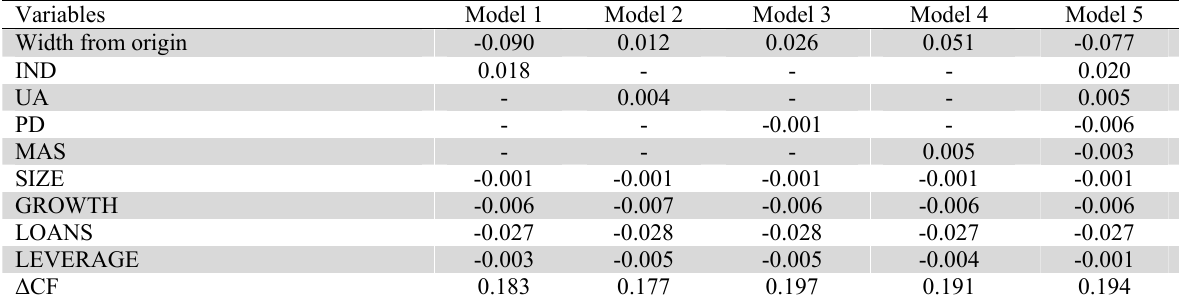
Estimating relationship between Δ ROA and independent variables (2005-